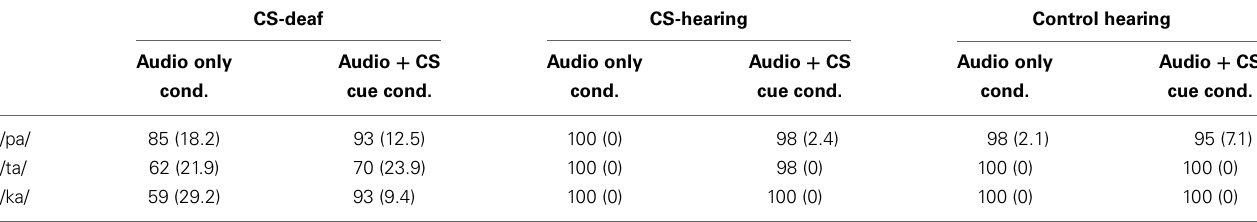
Table 5 | Mean percentages of correct responses for all groups in Lip-reading-Only and Lip-reading + CS cue conditions. CS-deaf CS-hearing Control hearing Lip-reading-Only Lip-reading + CS Lip-reading-Only Lip-reading + CS Lip-reading-Only Lip-reading + CS cond. cue cond. cond. cue cond. cond. cue cond. /pa/ /ka/ Standard deviations are indicated in parentheses.